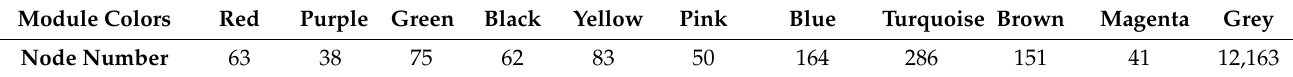
Table 2. The number of genes in the eleven coexpression modules.